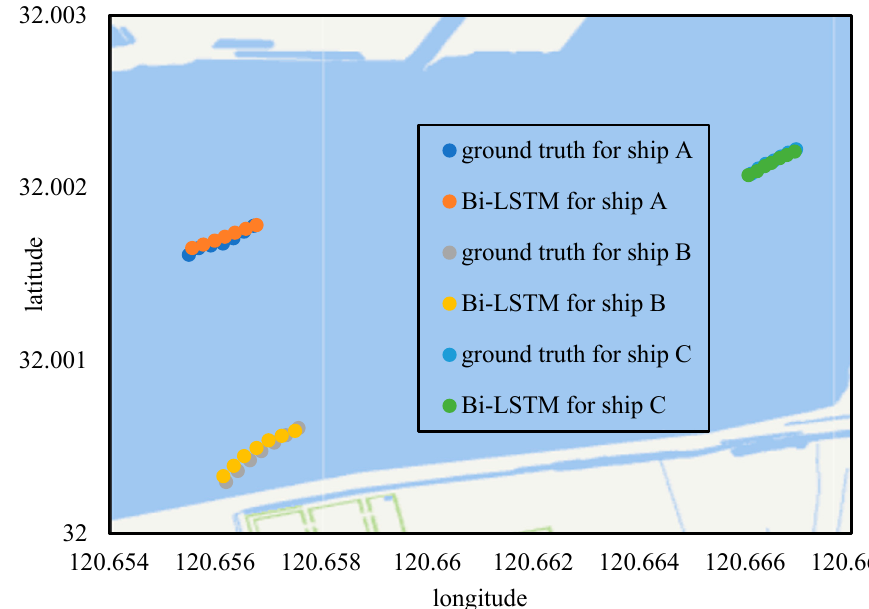
Figure 3. Bi-LSTM model prediction performance for different ships.